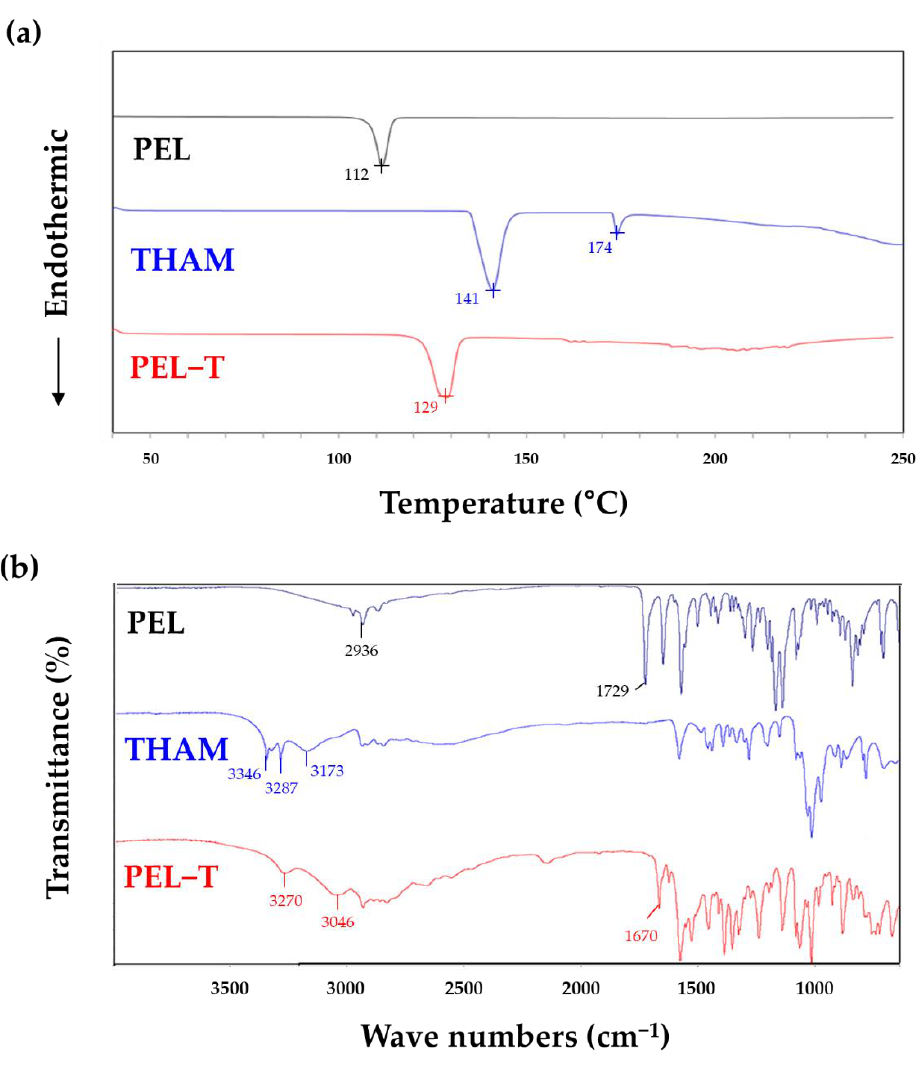
Figure 1. Structural characteristics of PEL-T. ( a ) DSC thermograms; ( b ) Fourier-transform infrared (FT-IR) spectra. PEL (black), THAM (blue), and PEL-T (red).